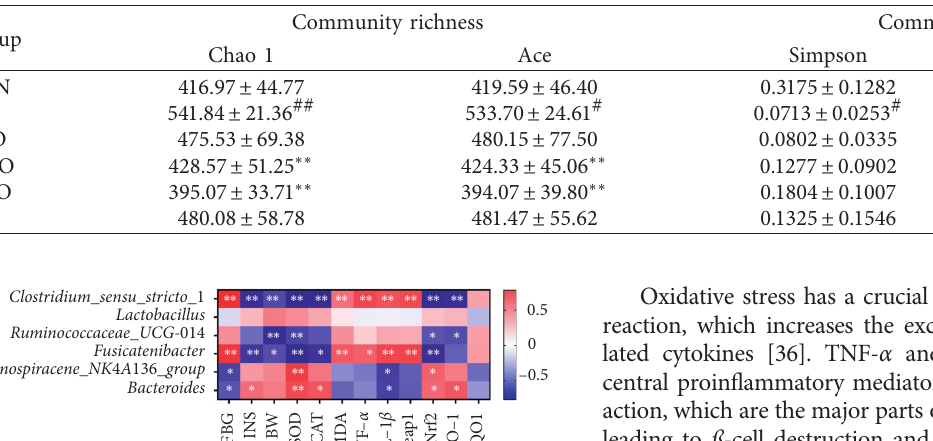
Table 1: Effects of almond oil on Alpha diversity.